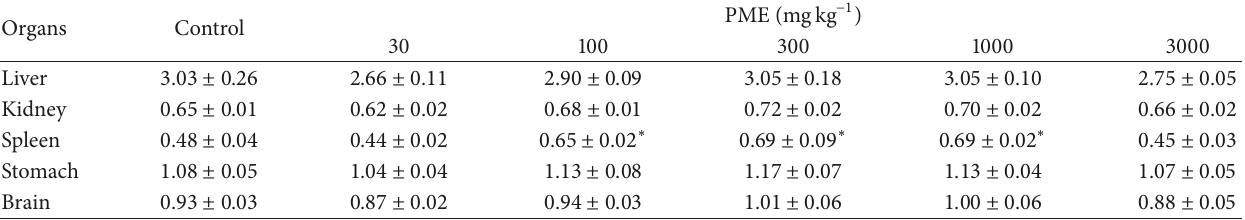
Table 2: Effects of PME on relative organ weights (ROW) of rats in the subacute toxicity test.